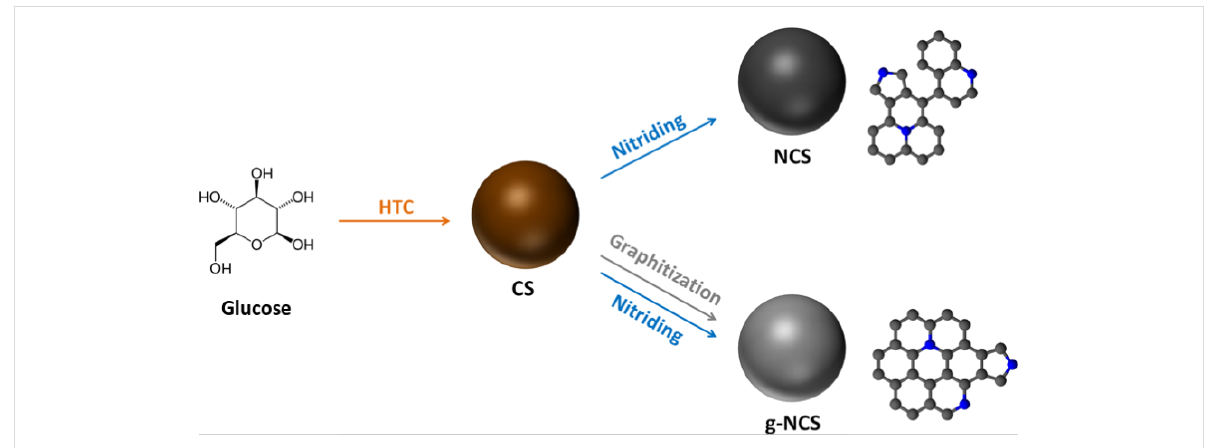
Figure 1: Schematic synthesis overview of amorphous N-doped carbon spheres (NCSs) and graphitized N-doped carbon spheres (g-NCSs) by hydrothermal carbonization (HTC) of a glucose solution yielding carbon spheres that are either directly nitrided with ammonia or graphitized and then nitrided (nitrogen atoms in the graphitic lattice are given in